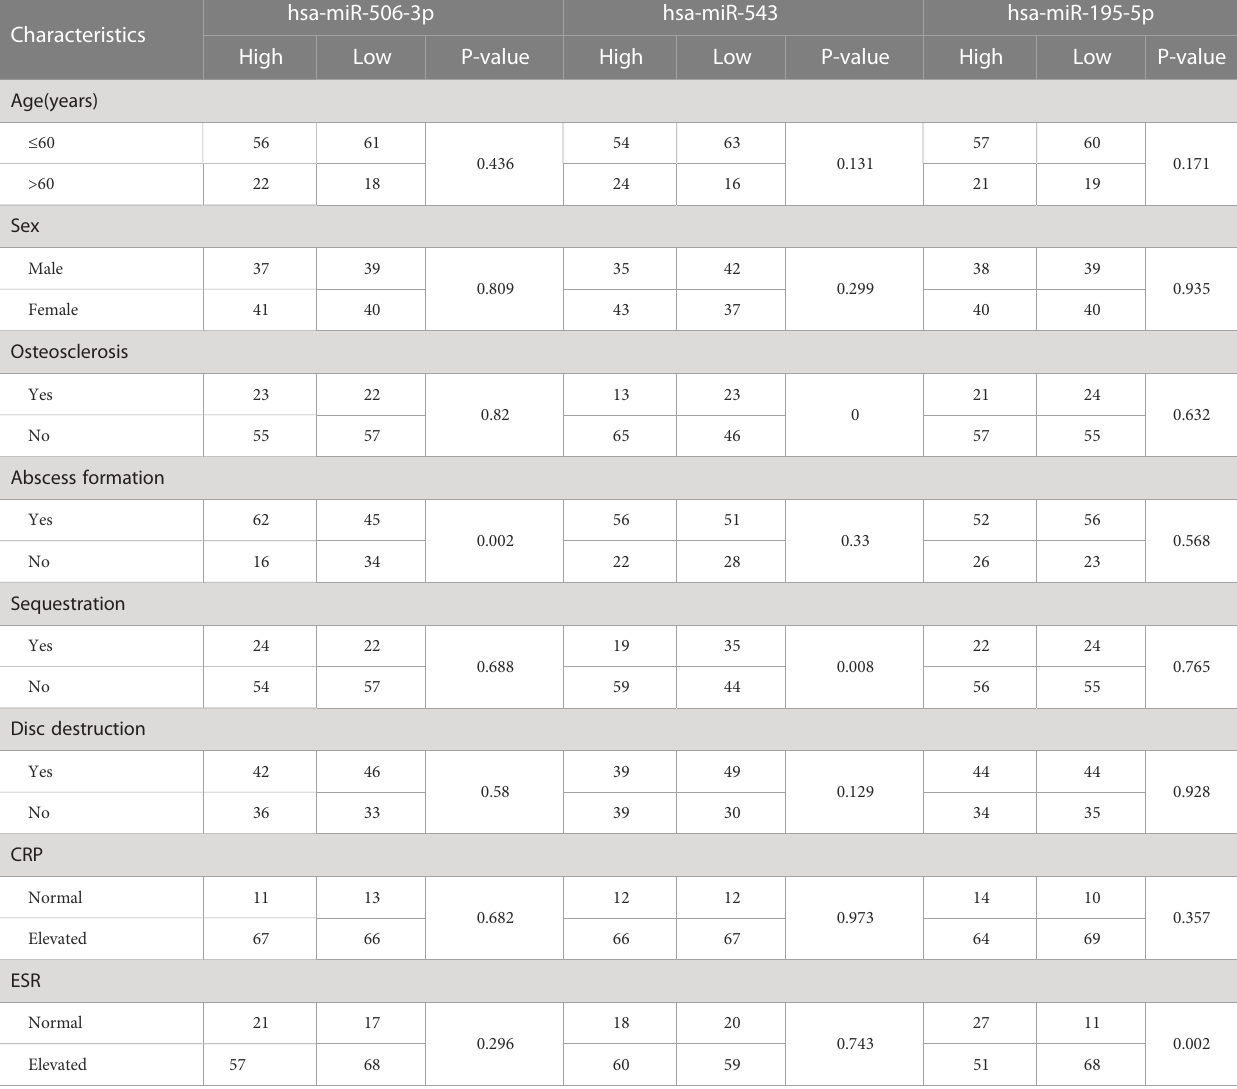
TABLE 3 Association of the expression levels of 3miRNAs with STB patient clinical characteristics.